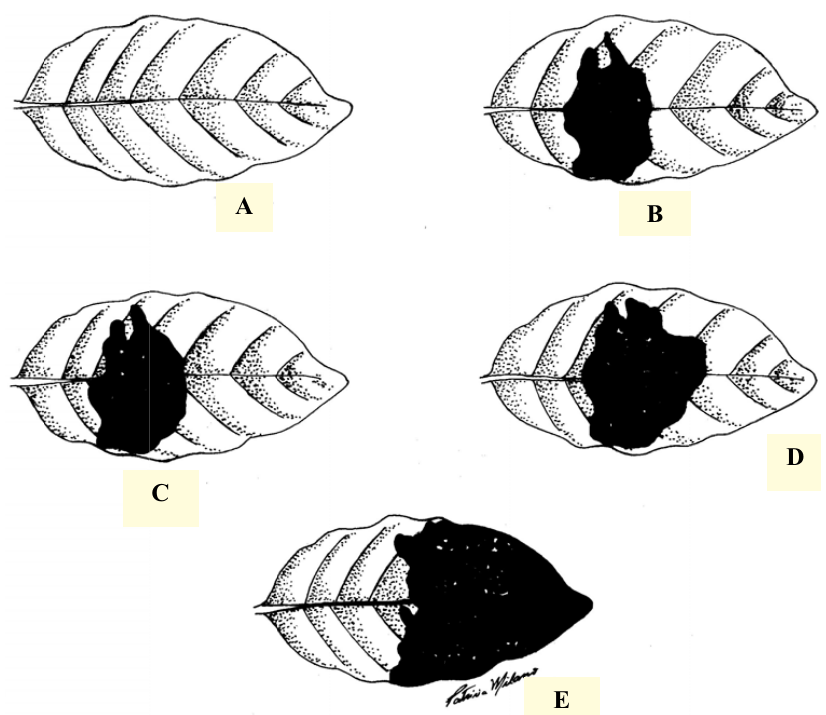
Fig. 2 – Damaged leaf area intervals of L. coffeella on Obatã coffee used to measure plant physiological parameters: 0% = healthy leaf (A); 25% of leaf area damaged (B); 26% of leaf area damaged (C); 36% of leaf area damaged (D); > 36% of leaf area damaged